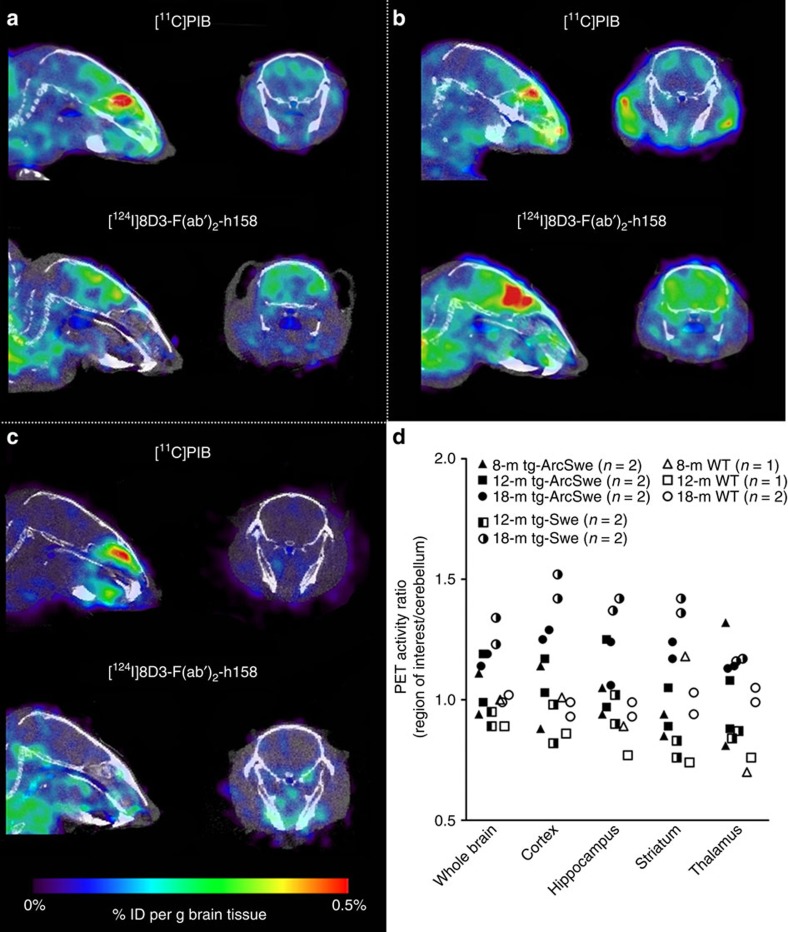
Comparison of PET imaging with [11C]PIB- and 124I-labelled fusion protein in transgenic and WT mice.PET images obtained during 60 min 72 h after injection of [124I]8D3-F(ab′)2-h158, or during 20 min, starting 40 min after injection of [11C]PIB. Transverse and sagittal views of one representative 18-month-old tg-ArcSwe (a), tg-Swe (b) and WT (c) mouse with the two radioligands. (d) PET image-based quantification of brain distribution of [11C]PIB relative to that in cerebellum for tg-ArcSwe, tg-Swe and WT mice in the different age groups (each symbol represents one animal). Representative PET images are shown in a–c. Number of animals included in each group is shown in d.